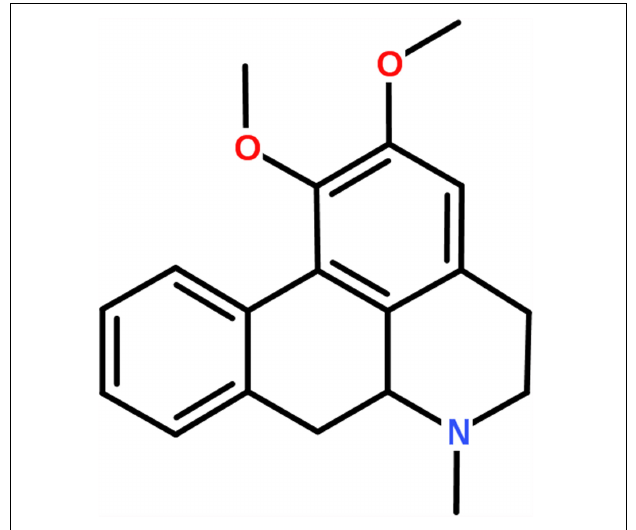
FIGURE 1 | Chemical structure of